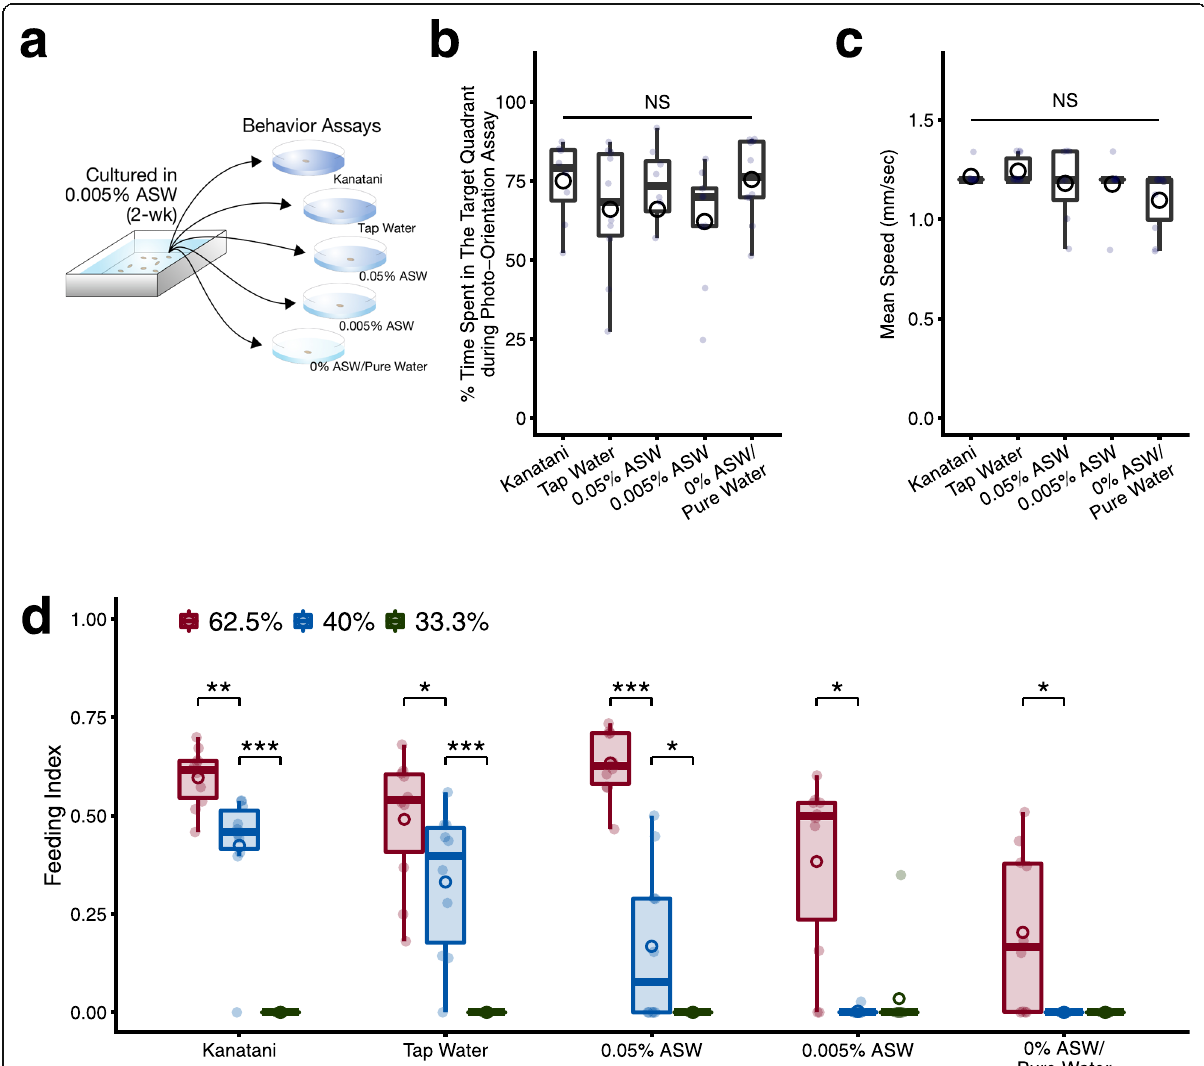
Fig. 3 Environmental water immediately affects and can restore feeding behavior specifically. a . A schematic illustration of the experimental design for behavioral assays in various environmental waters. Planarians grown in 0.005% ASW for at least 2 weeks were transferred to assay fields containing each type of environmental water and briefly subjected to behavioral assays. b . The percent time spent in the target quadrant during 90 s in the photo-orientation assay is shown as a box-and-whisker plot with mean (circles). c . Speed of movement (mm/sec) during photo- orientation assay. There were no significant differences (NS) in either the photo-orientation behavior or the motor activity among planarians bred in the different environmental waters (Kruskal-Wallis test). d . The concentration of ions in the environmental water determines planarians ’ sensitivity to the presence of food. The food intake was analyzed using colored food pellets containing different proportions of liver homogenate (33.3, 40, and 62.5%). Planarians cultured long-term with a low concentration of ions (0.005% ASW) showed restoration of the feeding behavior immediately after transfer into Kanatani water, tap water, or 0.05% ASW. The feeding index increased in a food-proportion-dependent manner. *, p < 0.05; **, p < 0.01; ***, p < 0.005 (Wilcoxon